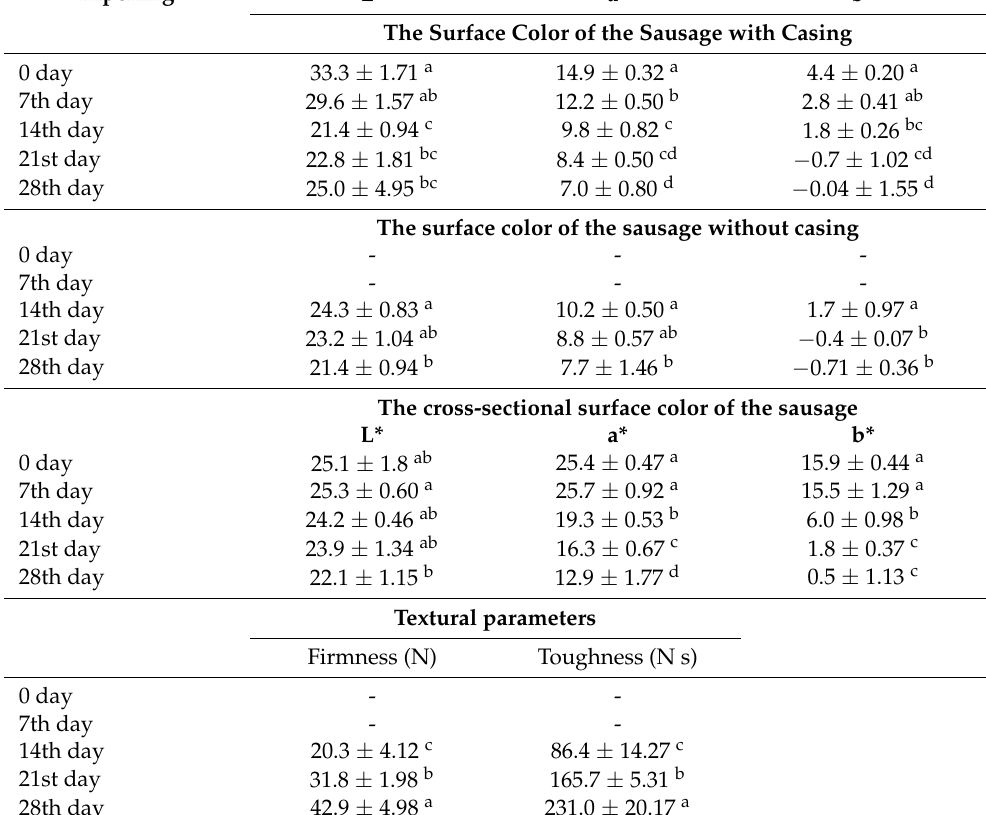
Figure 5. The colorimetric characteristics measured of the surface color of the sausage with and without casing ( a , c ) and cross-sectional surface ( b ). Table 3. The colorimetric and textural characterization throughout the ripening of “Pirot ‘ironed’ sausage. Ripening